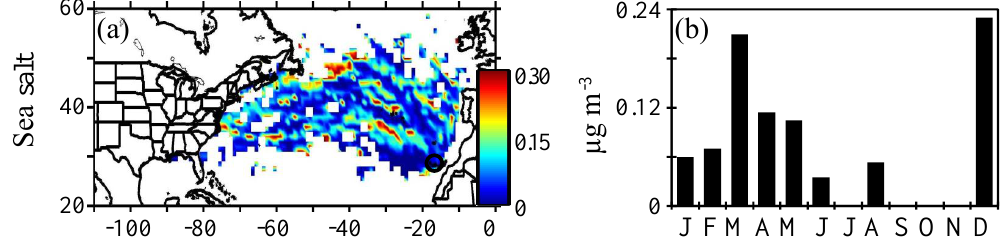
Figure 9. (a) Median Concentration At Receptor (MCAR) plots and (b) monthly median distribution for sea salt for the study period. The MCAR plots maximum concentration tick label includes concentration higher than this upper limit. The location of Izaña is highlighted (black